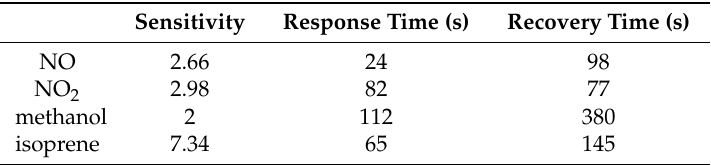
Table 1. Response of h -WO 3 to various gases of 1 ppm concentration at 350 ◦